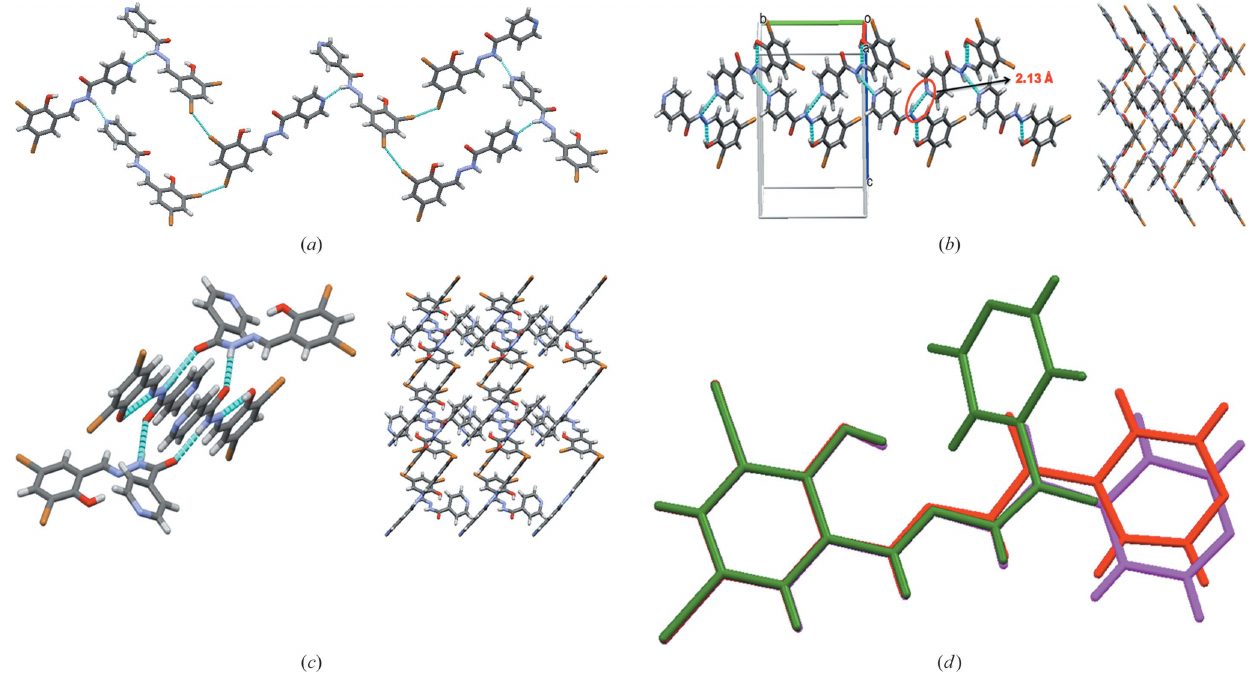
Figure 4 ( a ) Type II halogen-bonding interactions of Compound-B. ( b ) The one-dimensional chain propagating through the N—H (cid:2)(cid:2)(cid:2) N (pyridine) synthon (Form I) and packing of molecules along the c axis. ( c ) The tetrameric ring motif (Form II) and packing diagram (along the c axis). ( d ) Overlay of Form I (red) and Form II (green and magenta) of Compound-B.